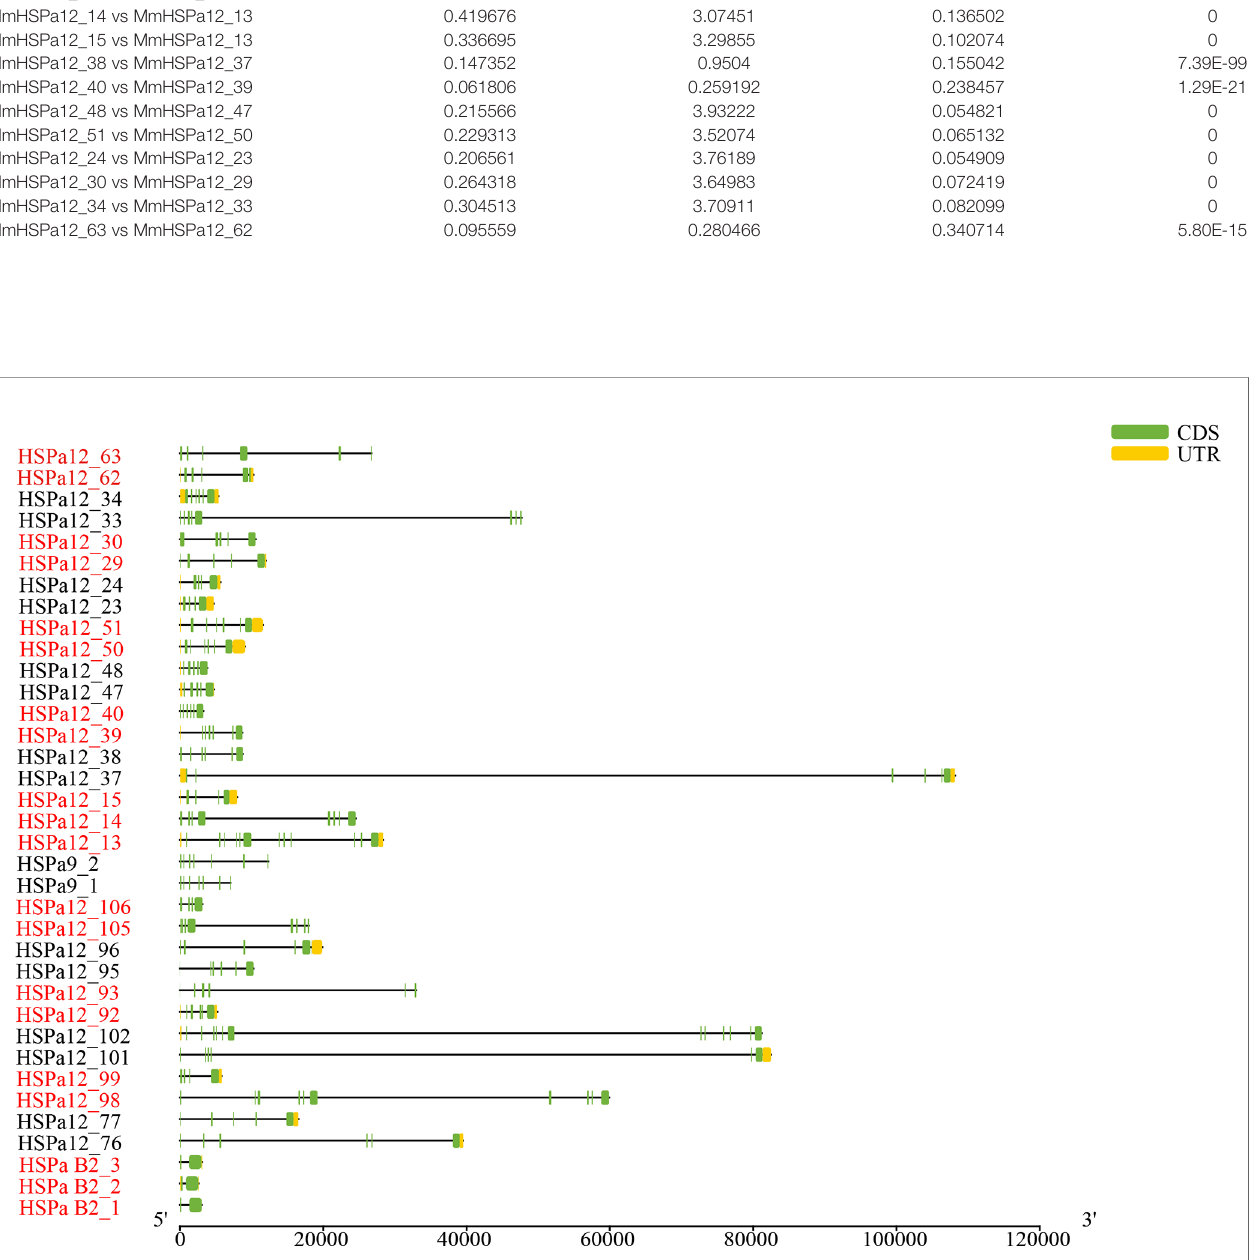
FIGURE 2 | Gene structure of M. mercenaria tandem duplication MmHSP70 gene pairs. Green boxes, black lines and yellow boxes represent exons, introns and untranslated region (UTR), respectively. The tandemly duplicated gene pairs were shown by adjacent two or three genes with the same